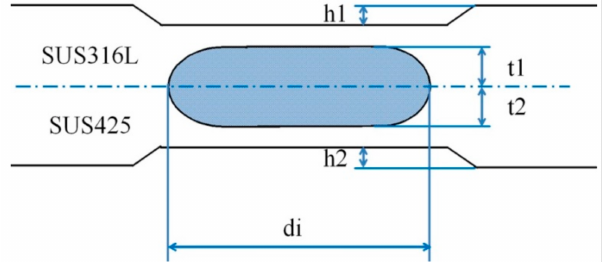
Figure 1. Cross-sectional schematic of SUS316L / SUS425 weldment in a transverse direction, where t1 and t2 are the depth of fusion, h1 and h2 the indentation depth, and di is the nugget